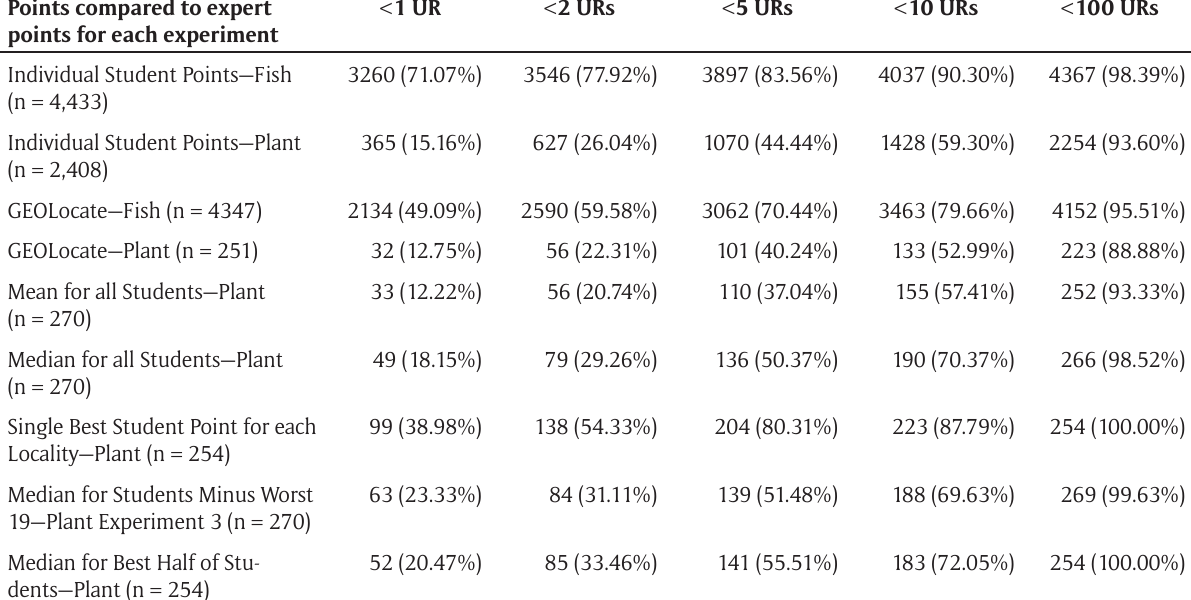
Table 1: Comparison of student points, consensus student points (using mean and median), and GEOLocate automated points to expert points measured by uncertainty radius (UR) for the fish and plant experiments. Because relatively few of the collection locations in the fish experiment were georeferenced by multiple students, we do not report compari- sons with the consensus student points for that